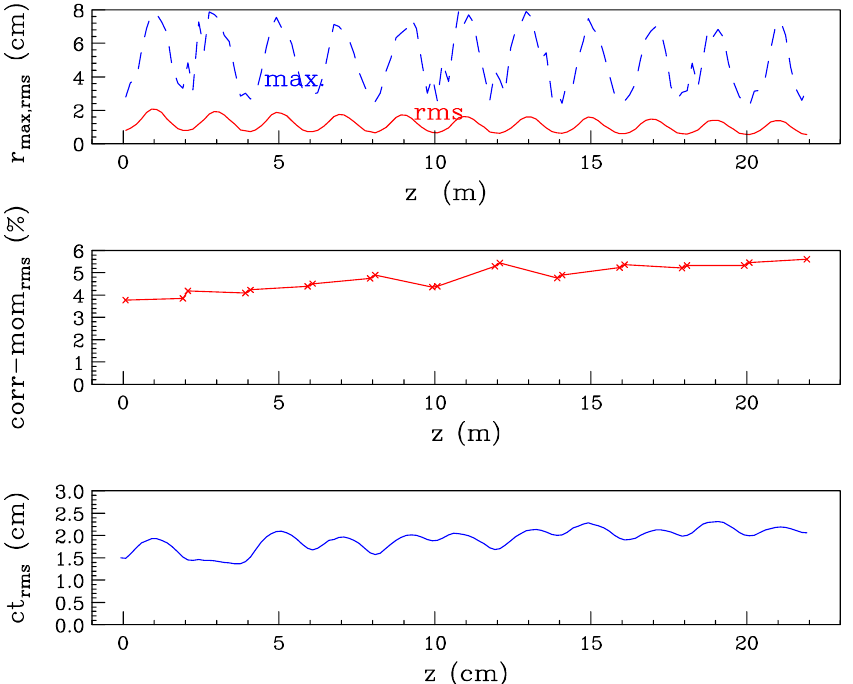
FIG. 27. (Color) (a) rms and maximum beam radii, (b) rms corrected momentum, and (c) rms bunch length, all vs z